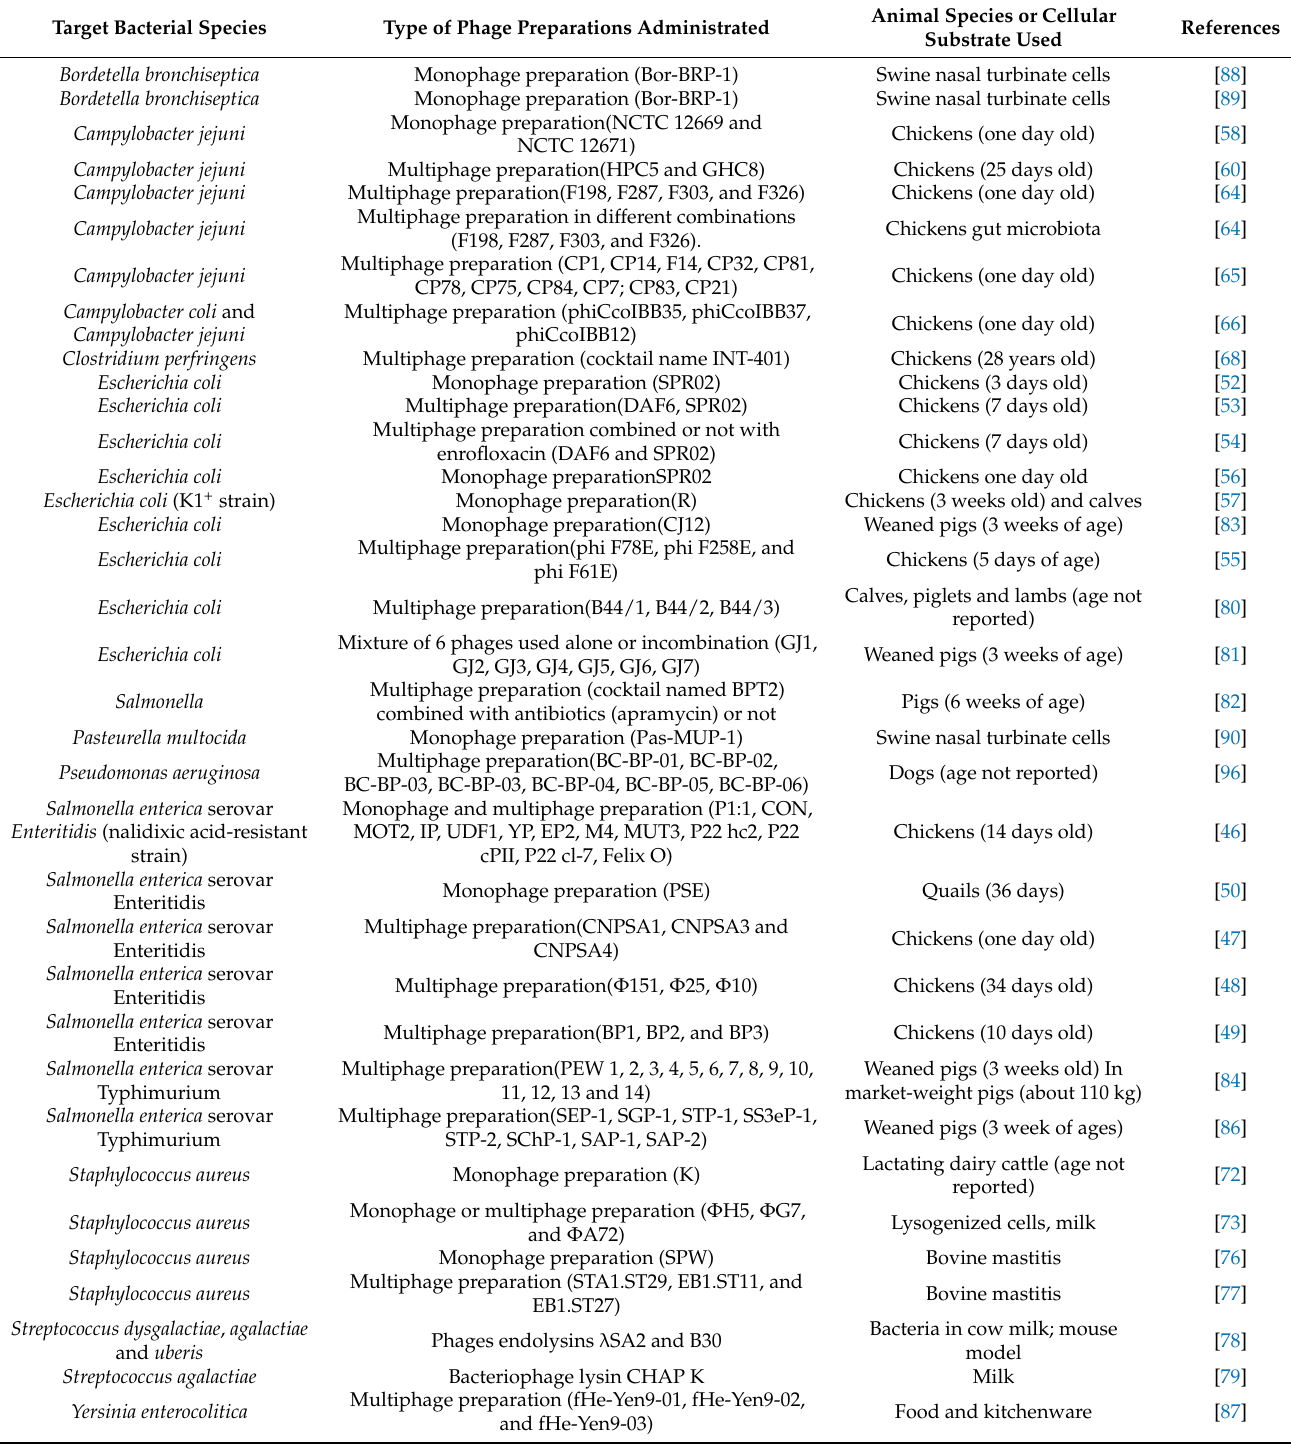
Table 1. Summary of the data analyzed in this manuscript (first column from the left: bacterial species analyzed in the study. Second column from the left: phage therapy utilized to reduce the bacterial species considered. Third column from the left: substrate used in the research to analyze the phages effect. Fourth column from left: reference number of the